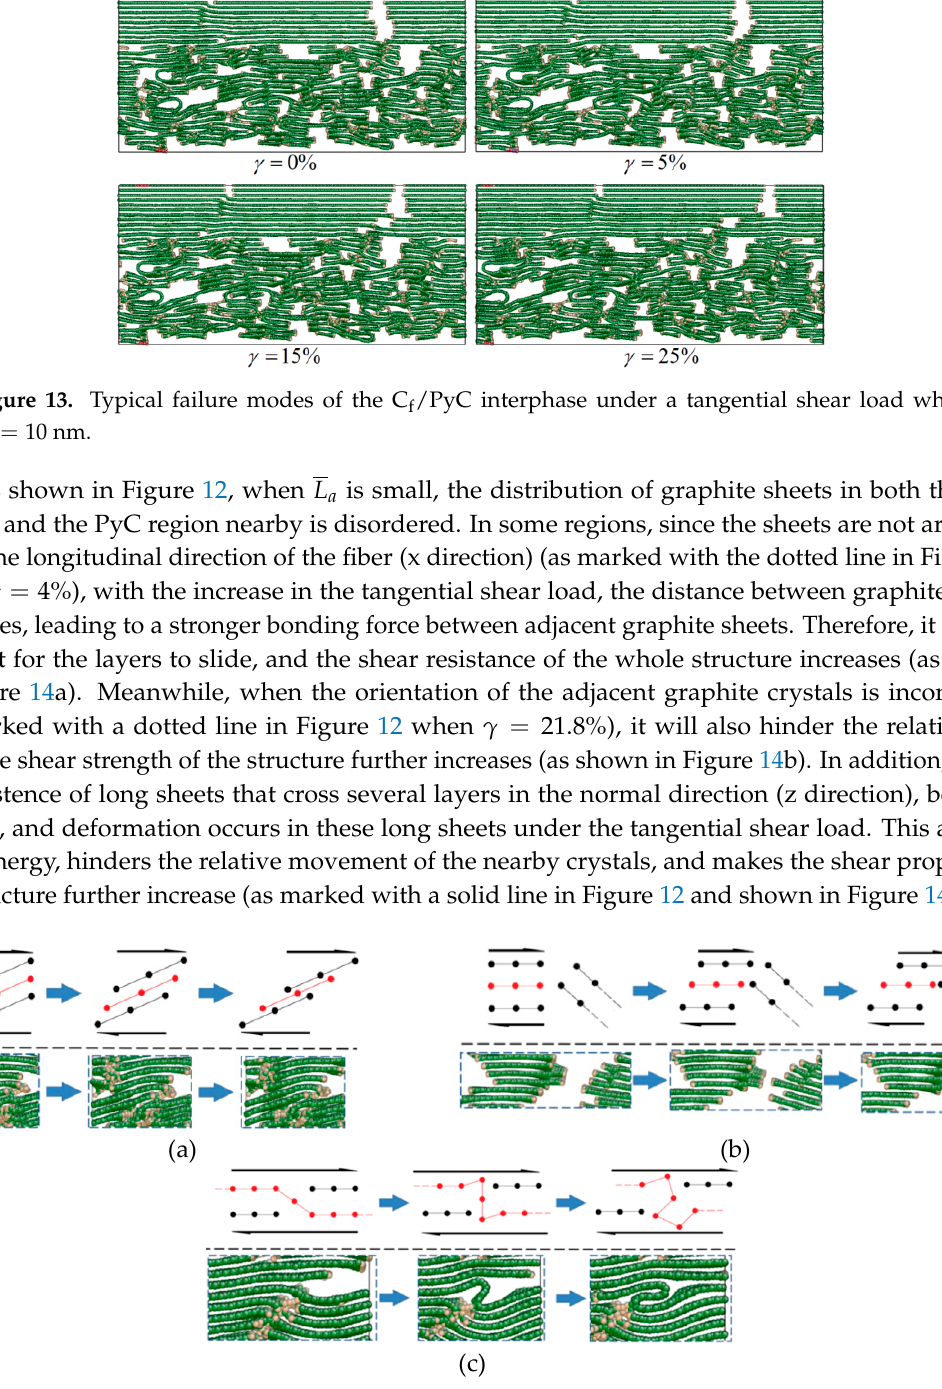
Figure 14. The main mechanism of the C f /PyC interphase to improve the shear mechanical properties when L a is smaller: ( a ) non-in-plane shear behavior; ( b ) the barrier between crystals; ( c ) long sheet folding.